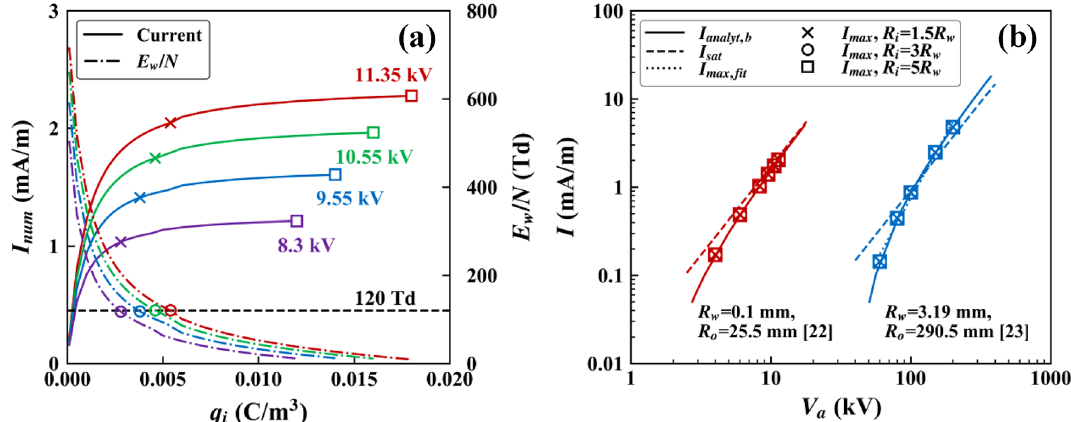
Figure 3. Results for the coaxial cylinders configuration: a saturation profiles of I num and E w / N for R w = 0.1 mm, R o = 25.5 mm, and R i = 3 R w , and b I anlayt , b , I sat , and I max under various calculation conditions.